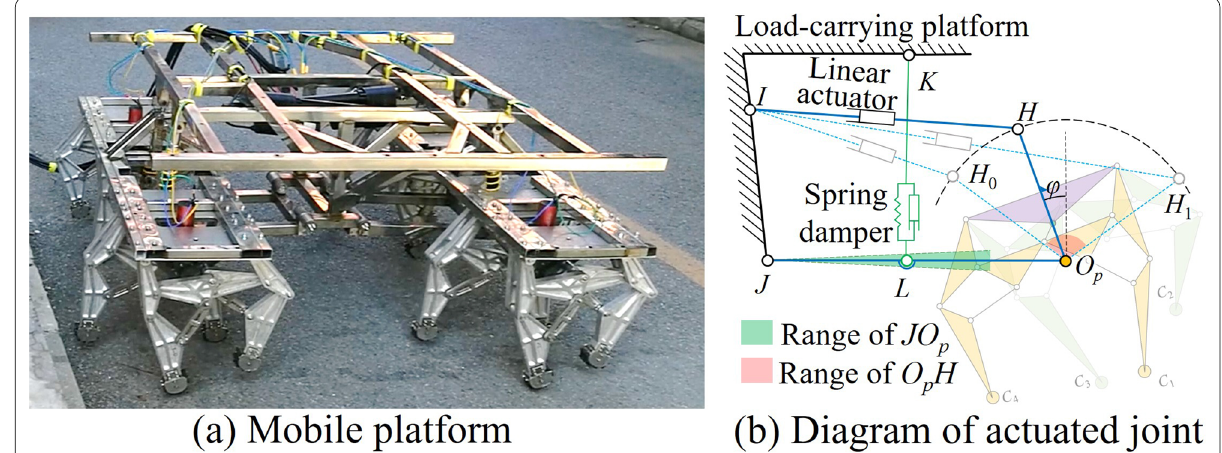
Figure 17 Experimental prototype